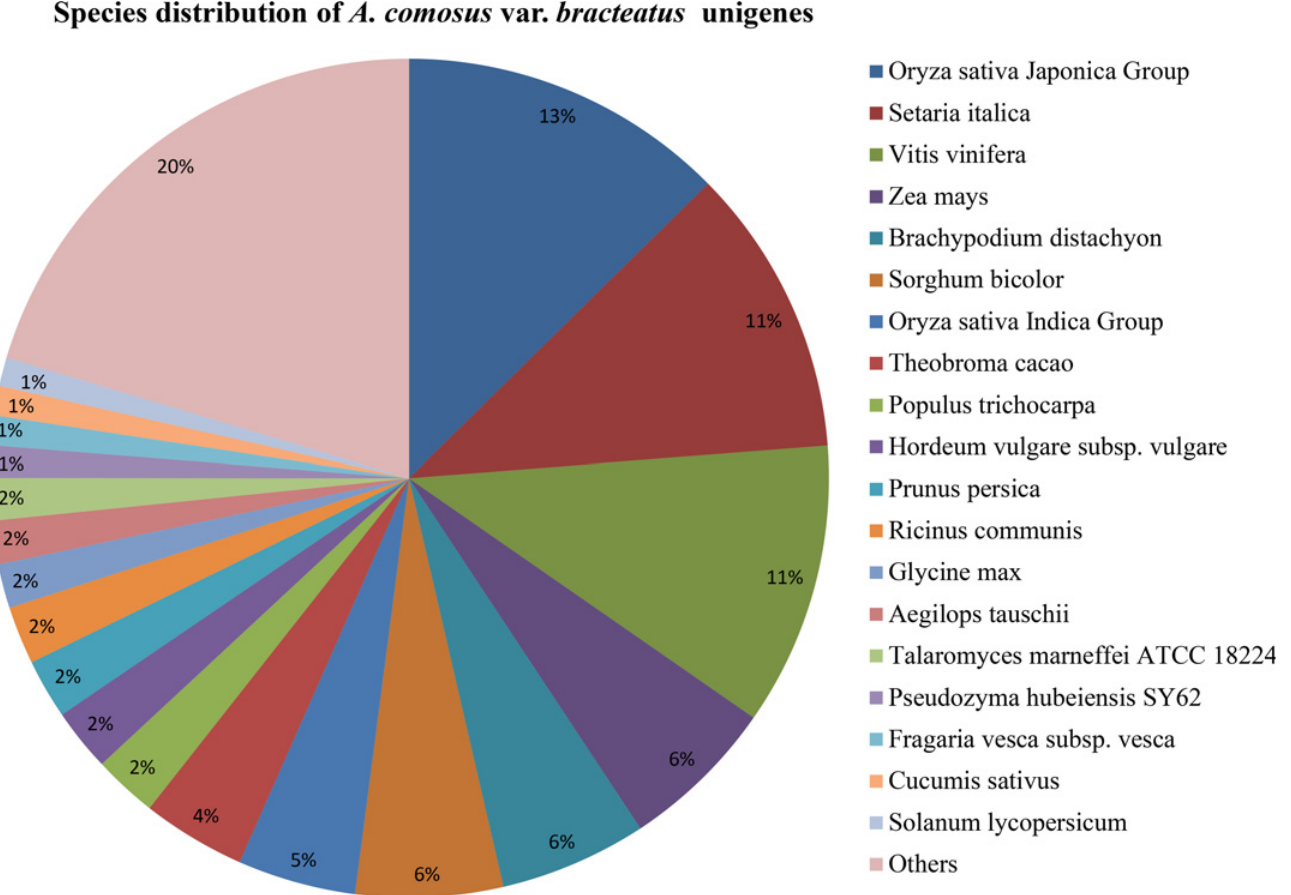
Fig 2. Species distribution of A . comosus var. bracteatus from the velvet de novo